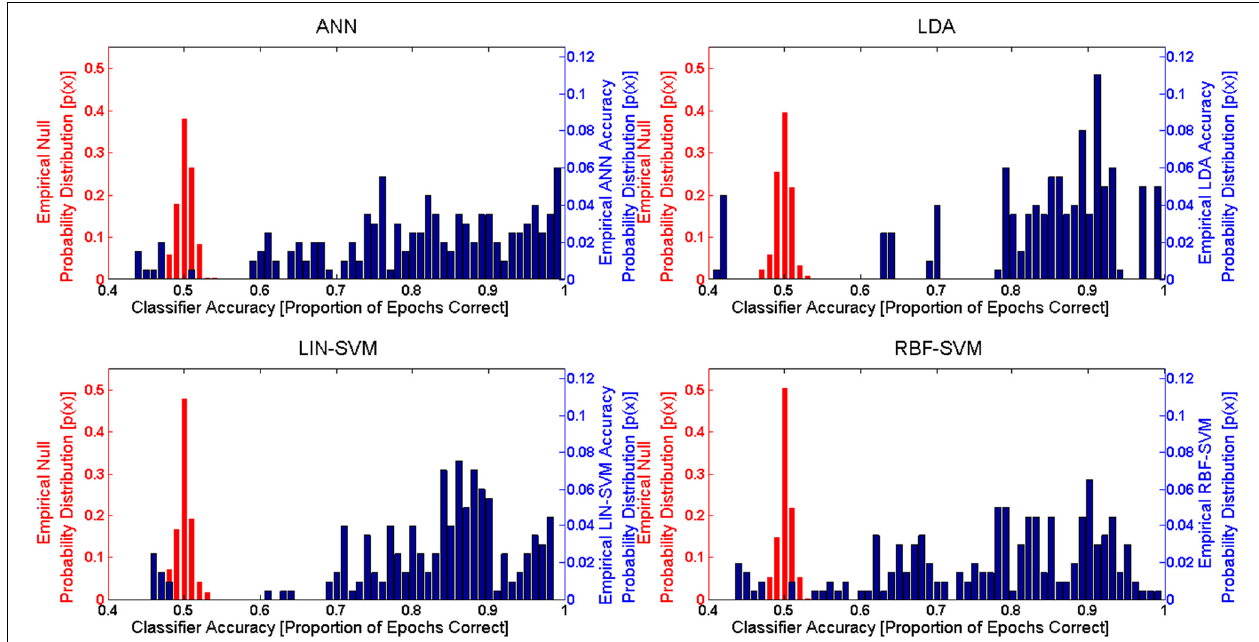
FIGURE 13 | Empirical probability distribution functions for both the null (left y-axis, in red) and between-session (right y-axis, in blue) classifier accuracies for each of the four learning approaches. These empirical probability distribution functions are derived from the k-Fold procedure ( k = 10) for both the empirical and between-session (S2) test sets. Note that the left y-axis (for null) and right y-axis (between-session) scales are different